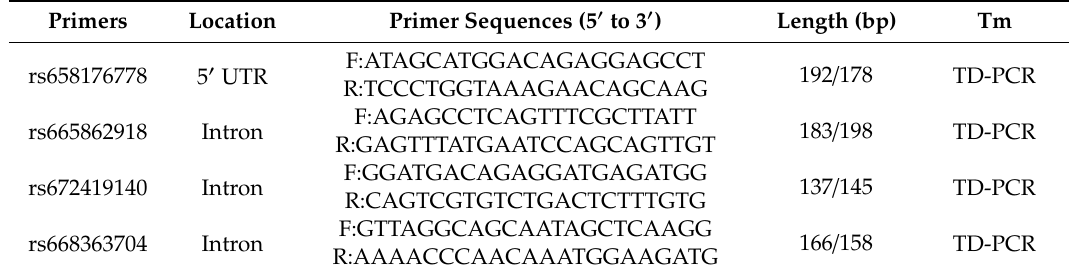
Table 1. PCR primers used for detecting indels in the goat HIAT1